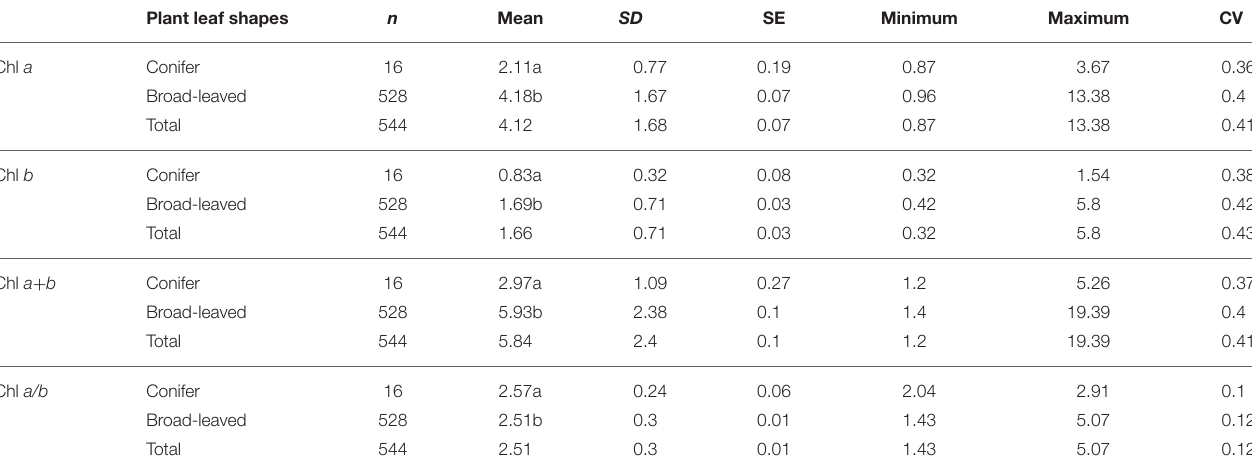
TABLE 3 | Statistics of leaf chlorophyll content (mg g − 1 ) for different leaf shapes in forests. Plant leaf shapes